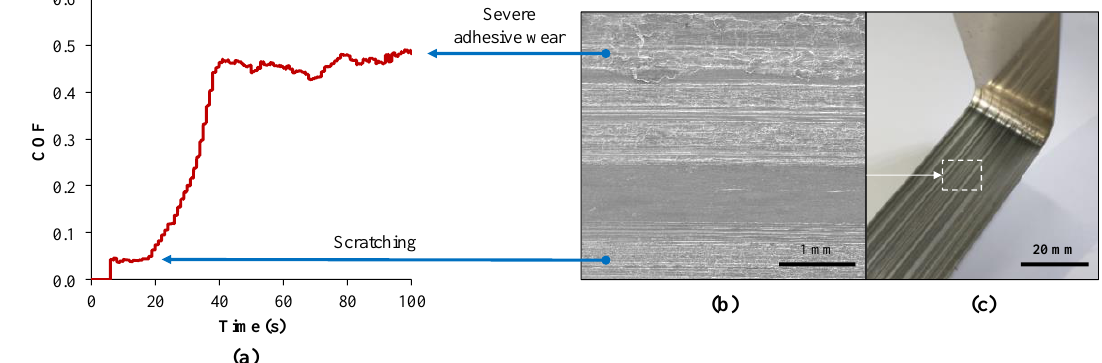
Figure 9. ( a ) Friction characteristic curve with two stages of friction (BUT test); ( b ) Image showing the change from scratching to severe adhesive wear; ( c ) Specimen with a high degree of discoloration and galling.